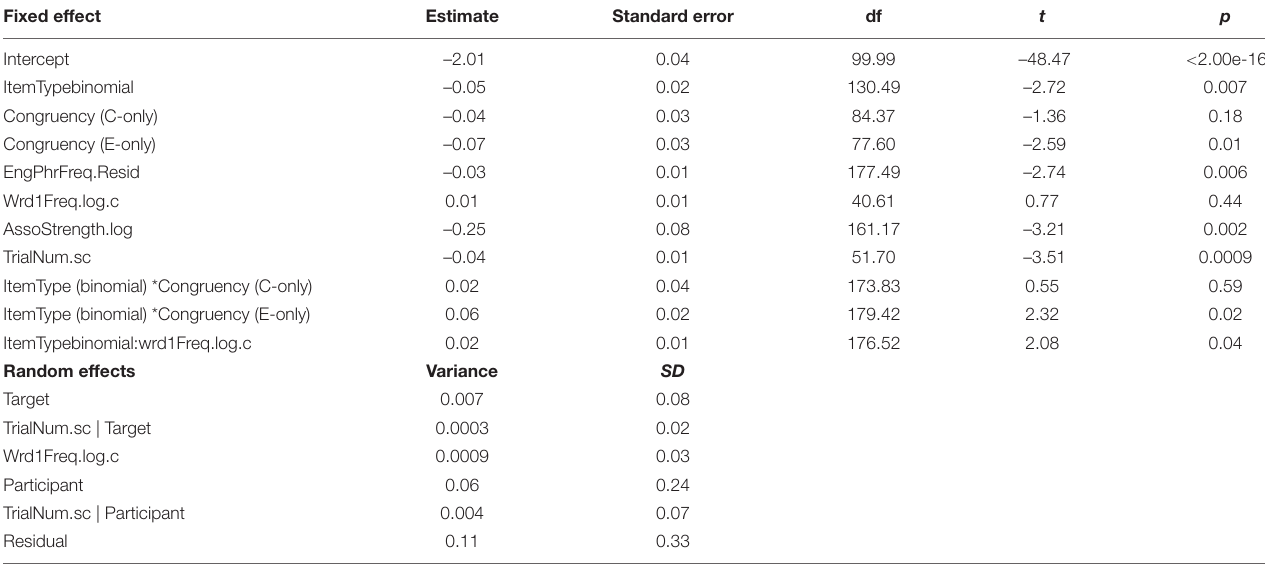
TABLE 7 | Results of mixed model for English–Chinese